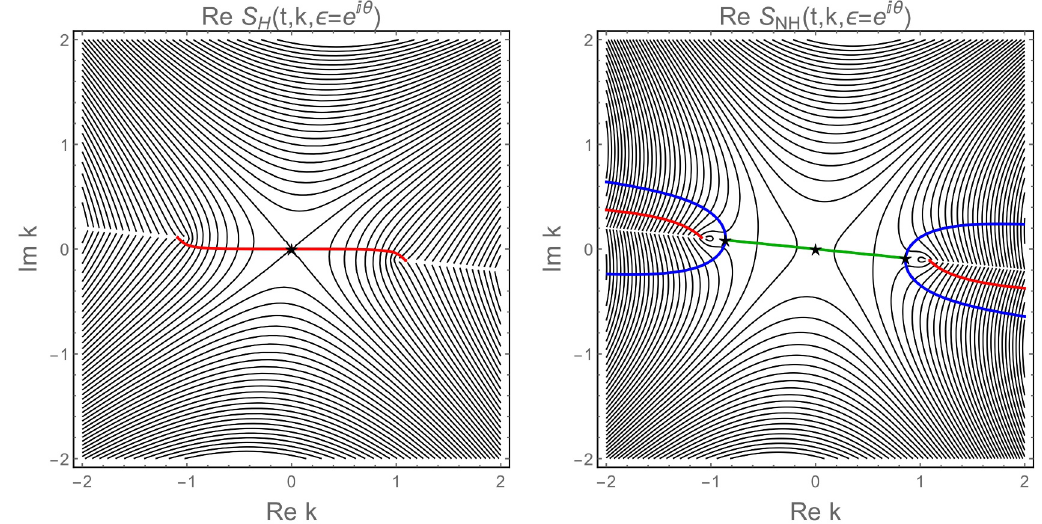
Figure 4 . Level plots of the saddle point actions Re S H ( t, k ) (left) and Re S NH ( t, k ) (right) for (cid:15) = e iθ for Gaussian initial data (2.22) with s = 1 , t = 0 . 5 and θ = 0 . 1 . The saddle points are denoted by the black stars and associated steepest descent paths are shown in red ( k = 0 , hydrodynamic), green ( k , nonhydrodynamic) and blue ( k ). The red path crosses the branch cuts 0 ± (visible as white discontinuities in the plots) and continues on the other sheet, while the green path ends at the k ±